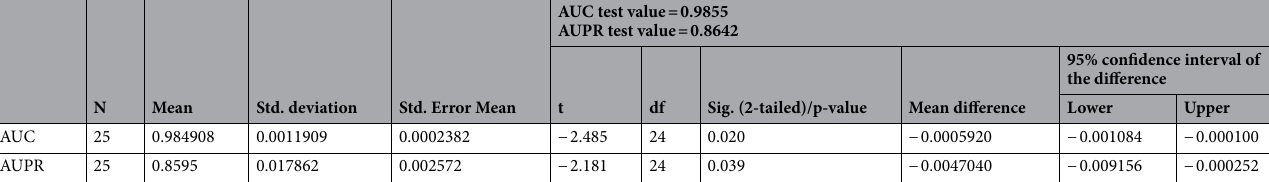
Table 1. AUC and AUPR one-sample T test.